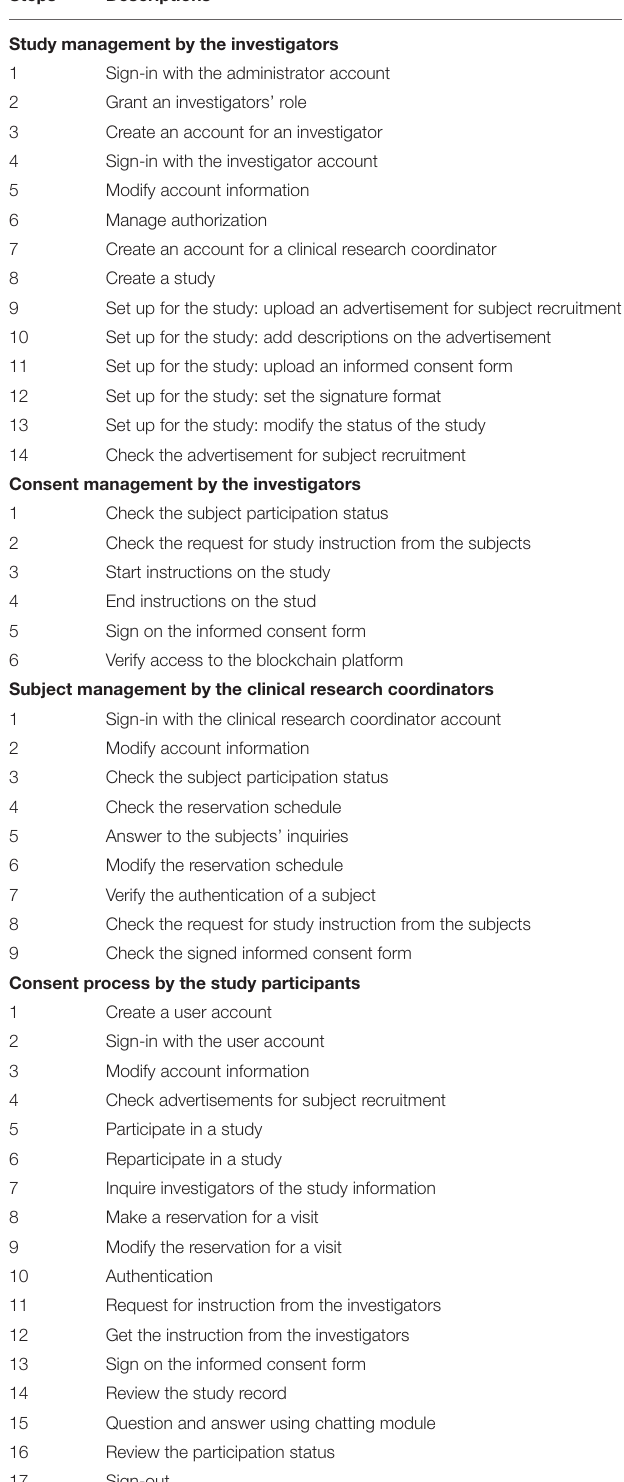
TABLE 1 | User acceptance test